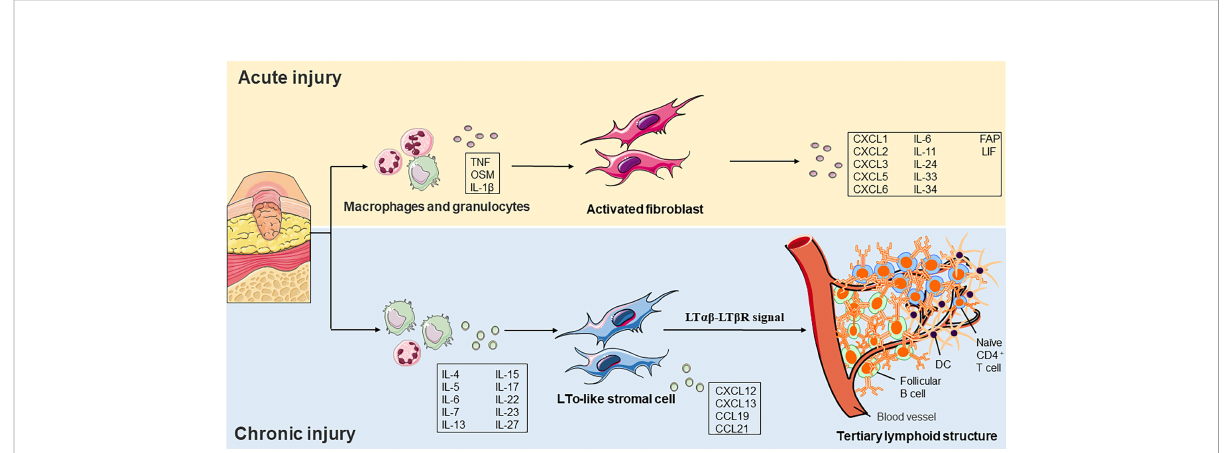
FIGURE 3 Role of fi broblast functions in acute and chronic injury. a) In acute injury, tissue damage activates pathogen – and damage – related molecular patterns on macrophages and granulocytes. Cytokines subsequently released by these cells, such as TNF or OSM, and IL – 1 b induce a pro – in fl ammatory phenotype fi broblast formation. b) The local cytokine environment initiates LTo – like stromal cells in a chronic in fl ammatory environment. It induces the expression of chemokines such as CCL19, CCL21, CXCL12, and CXCL13. LTo – like stromal cells recruit immature CD4+ T cells, LAMP3+ DCs, and follicular B cells and eventually form a tertiary lymphoid structure. TNF, tumor necrosis factor, OSM, oncostatin M, IL, interleukin, LTo, lymphoid tissue organizer, CCL, CC – chemokine ligand, CXCL, CXC – chemokine ligand, DC, dendritic cell, FAP, fi broblast activation protein, LIF, leukemia inhibitory factor, LT b R, lymphotoxin – b